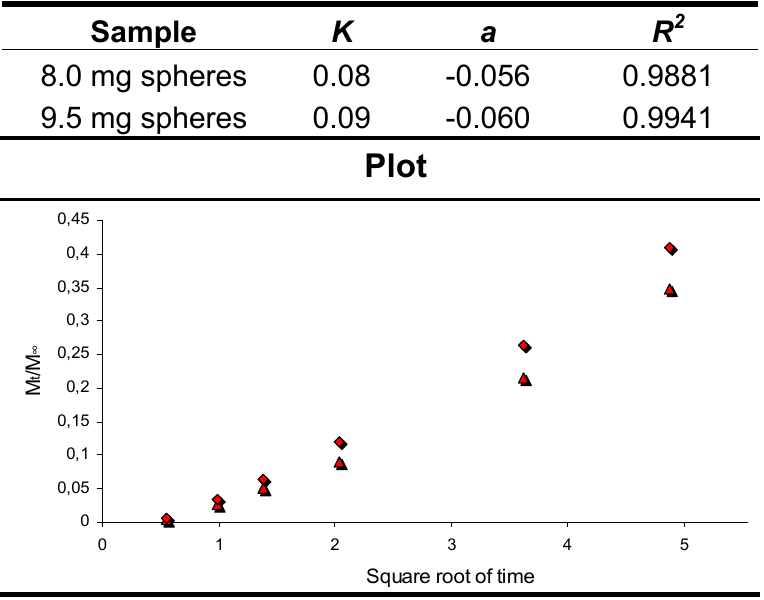
Table 2. Slope K , axis intercept a , squared coefficient of correlation R 2 and the plot from equation (2) for the release of Pac (over time in hours) from microspheres embedded